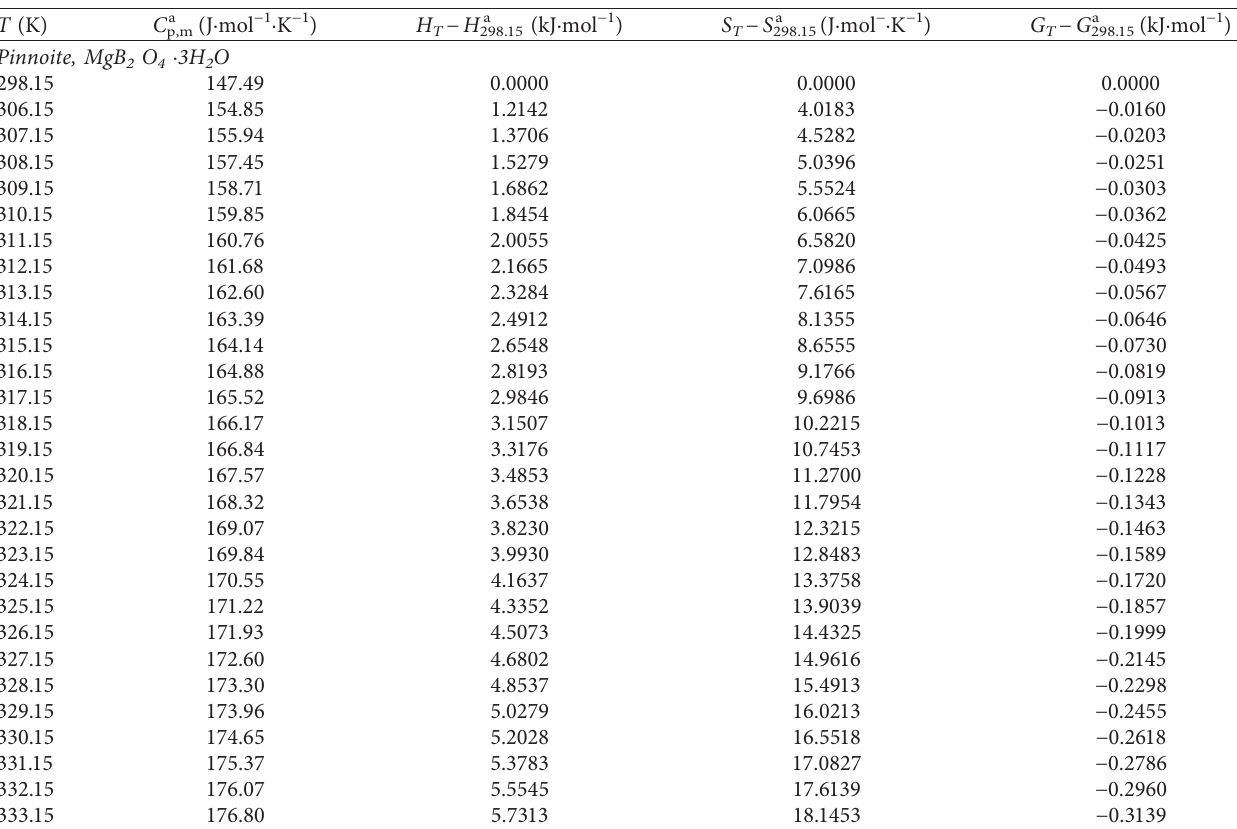
− H − S − G T 298.15 ), ( S T 298.15 ), and ( G T 298.15 ) of pinnoite and